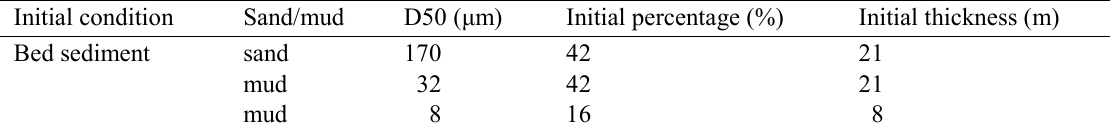
Table 2 Three sediment fraction set for the